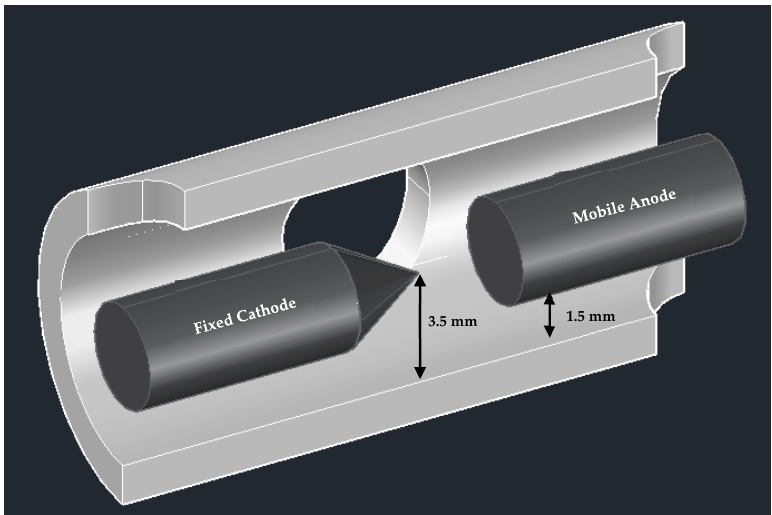
Figure 27. Isometric cross-sectional view of the LINE-OX ® porous mullite substrate with electrodes.